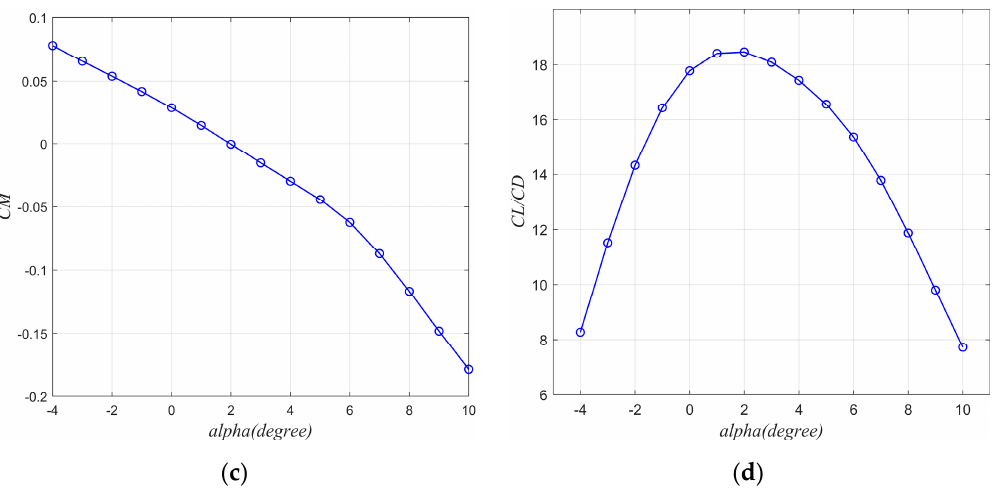
Figure 8. Computational Fluid Dynamics (CFD) result of cruise at 5000-m altitude of the UAV: ( a ) Lift coefficient, angle of attack data; ( b ) drag coefficient, angle of attack data; ( c ) pitching moment coefficient, angle of attack data; ( d ) lift–drag ratio data.